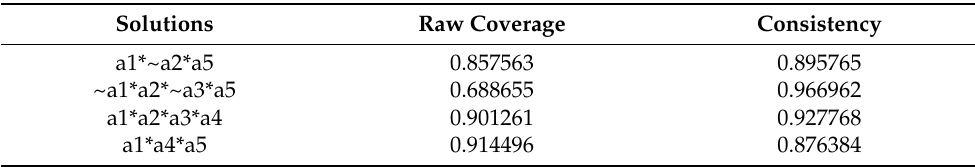
Table A12. Success pathways (outcome A3)-.